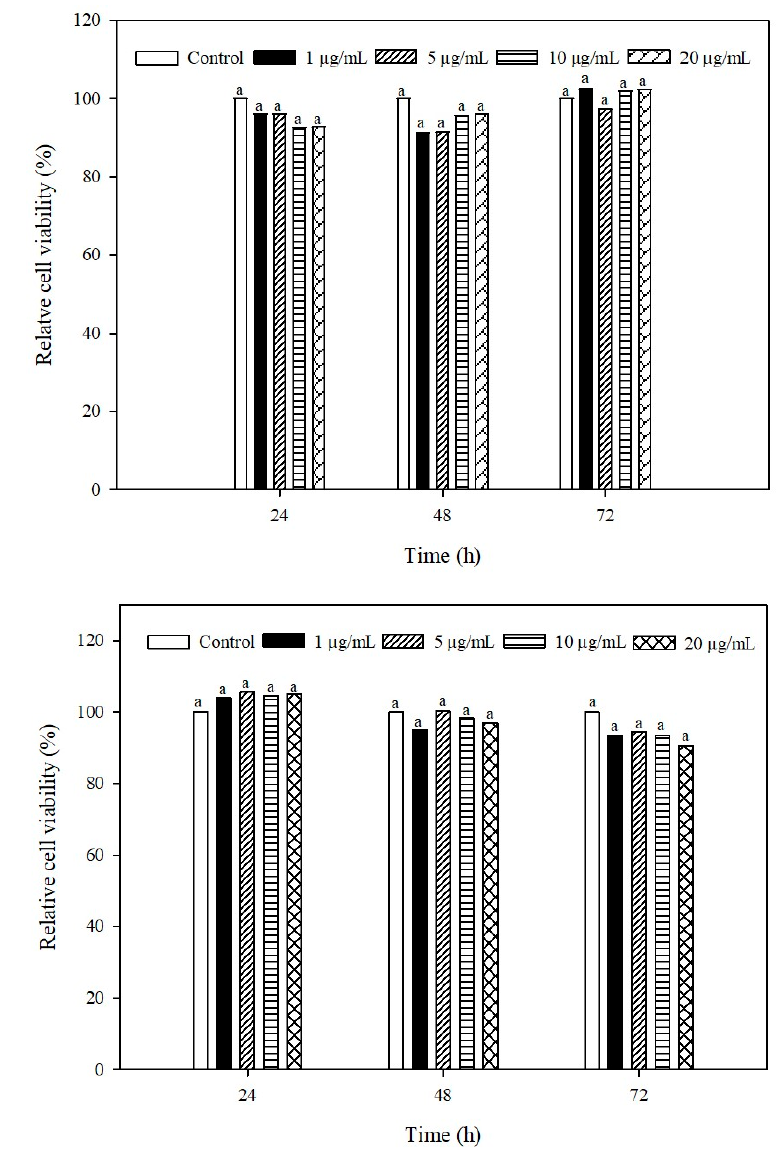
Figure 5. Cytotoxicity of the IFN- α overexpressed in ( A ) E. coli ( B ) B. subtilis against grouper kidney (GK) cells by MTT assay. The GK cells were incubated with E-IFN for 24, 48, and 72 h prior to MTT assay. The O.D. at 540 nm of each group was compared to the untreated control cells. Data are expressed as mean ± SD (n = 3). Different letters at the top of the bars are significantly different ( p < 0.05).